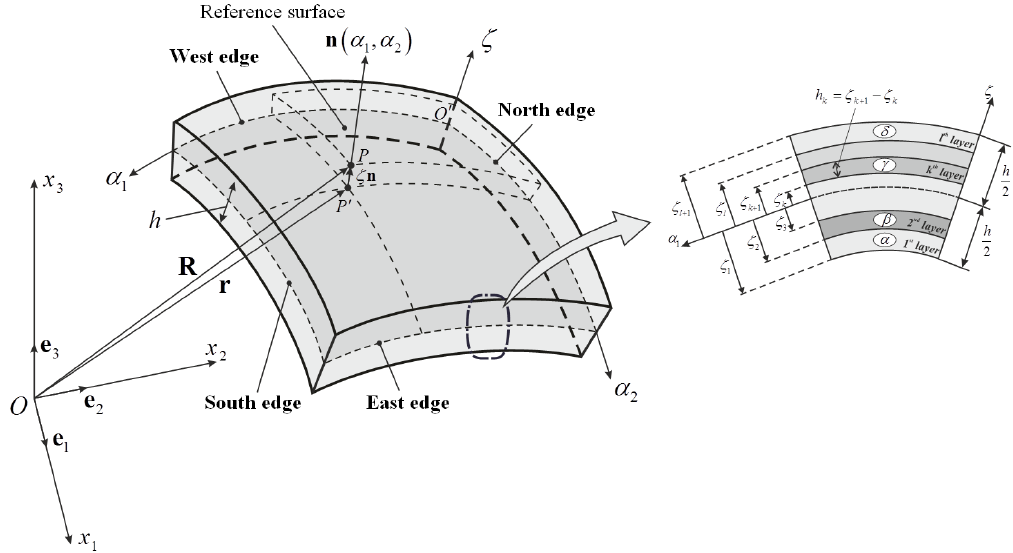
Figure 1. Representation of a generic doubly-curved shell element, edge identification and lamination scheme.